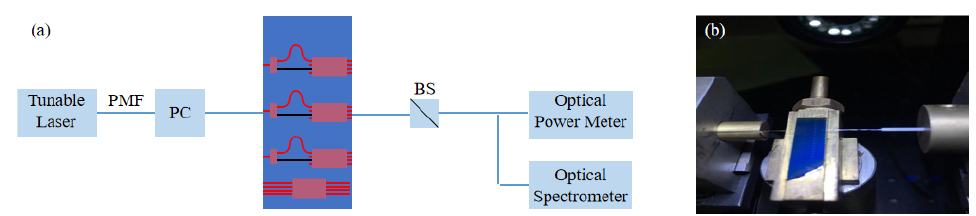
Figure 11. The ( a ) test bench and ( b ) coupling system for testing the response spectra of the fabricated 90 ◦